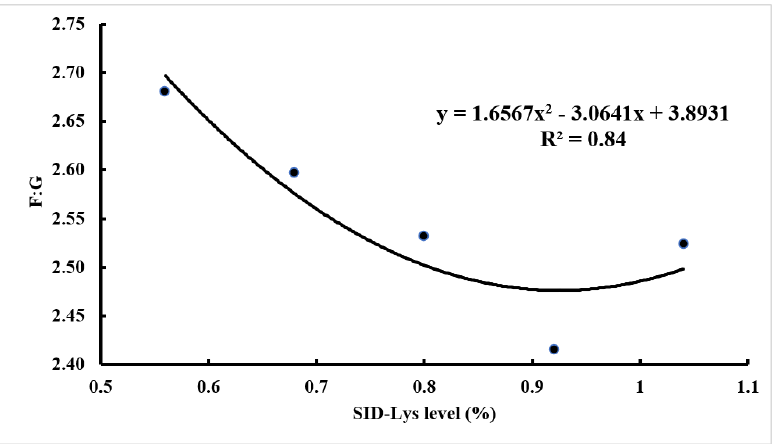
Figure 1. Quadratic regression trends between dietary SID Lys level and F:G of Baqing pigs for 20–40 kg.